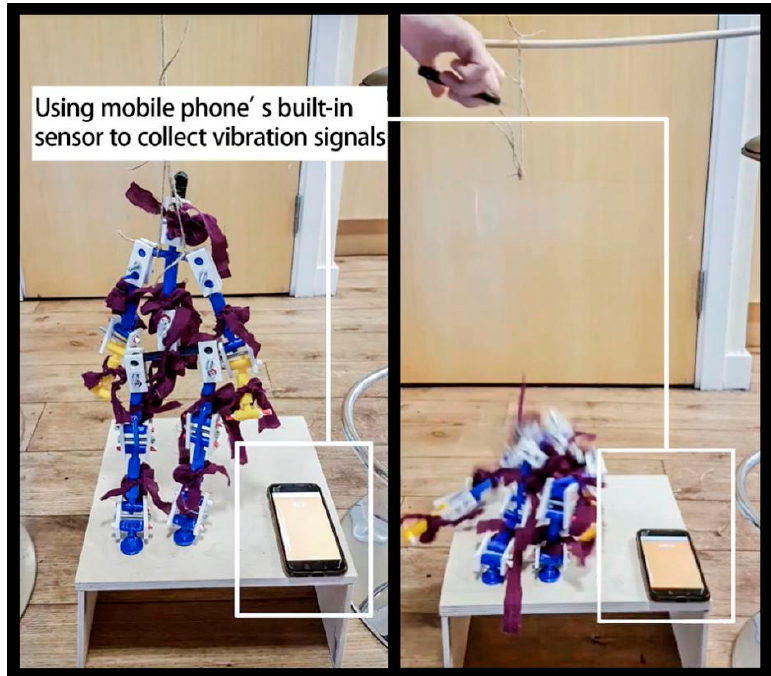
Figure 4. Model load (data source [42]).